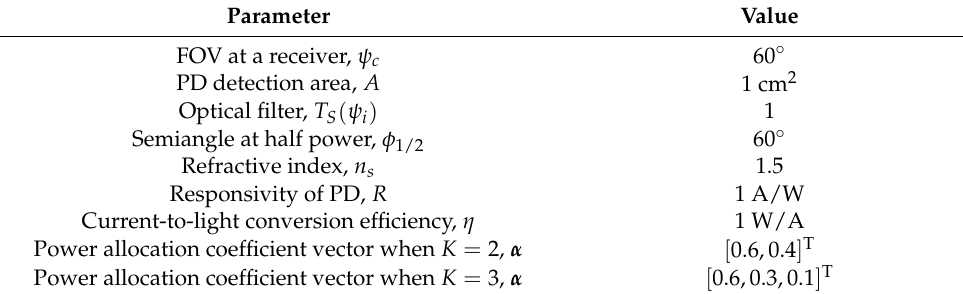
Table 4. Experiment parameters. Parameter Value Power allocation coefficient vector when K = 2, α Power allocation coefficient vector when K = 3,